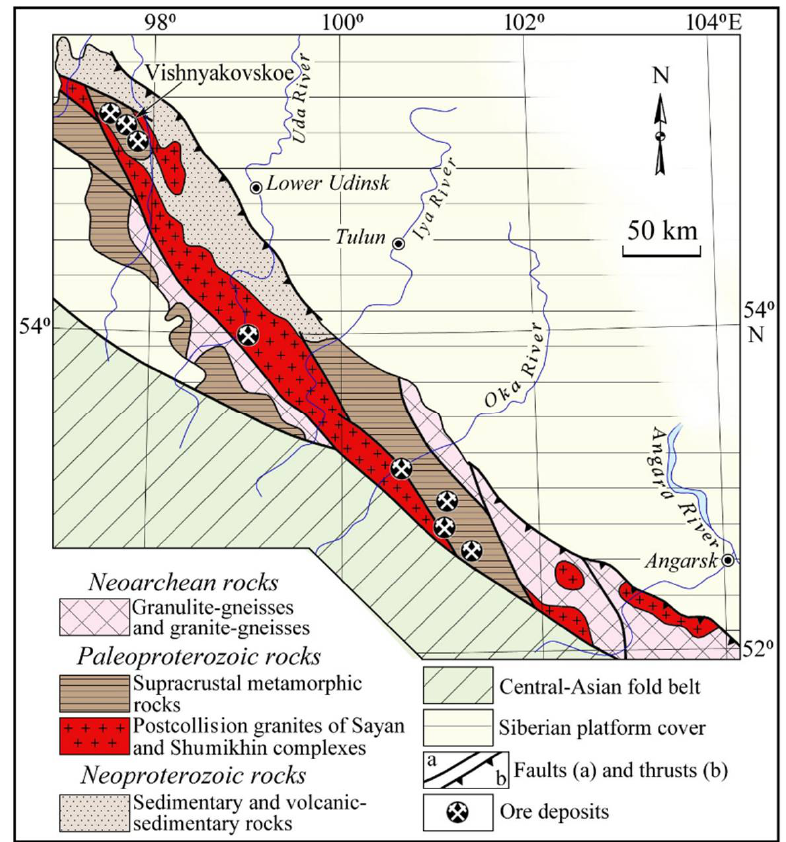
Figure 2. The East Sayan belt of rare metal pegmatites, eastern Siberia (modified from Sal’nikova et Figure 2. TheEastSayanbeltof raremetalpegmatites, easternSiberia(modified fromSal’nikovaetal. al. [48]).